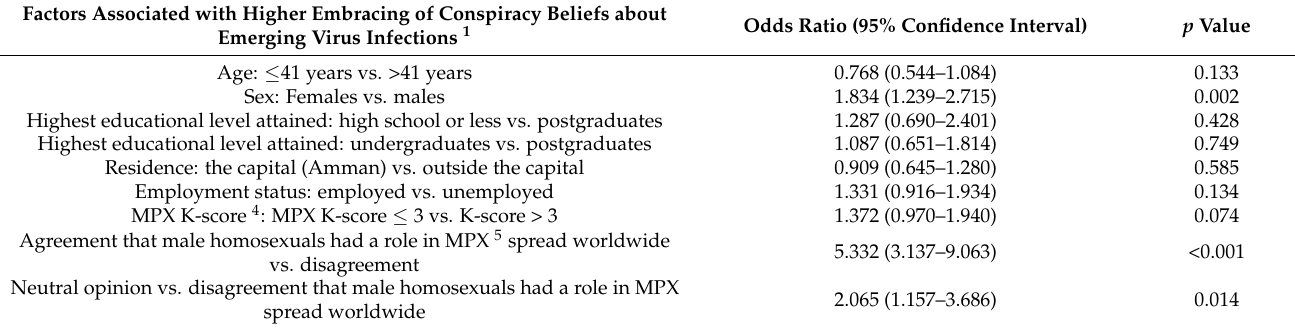
Table 3. Multivariate analysis to assess the embracing of conspiracy beliefs regarding emerging virus infections with different study